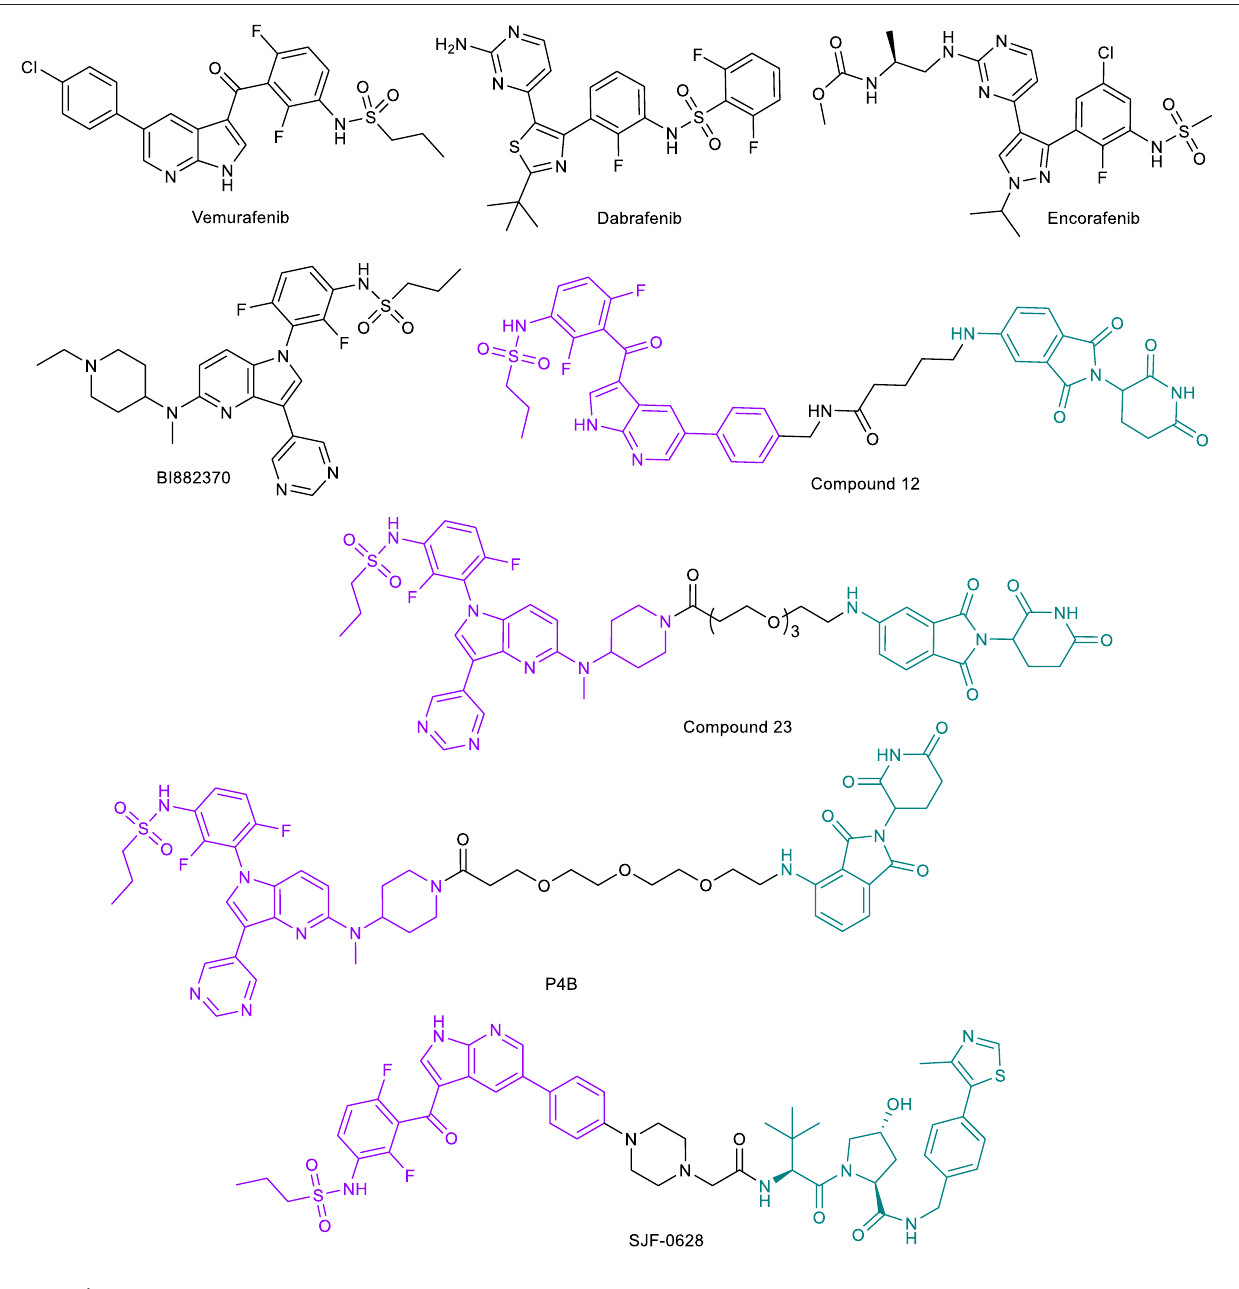
Frontiers in Cell and Developmental Biology |